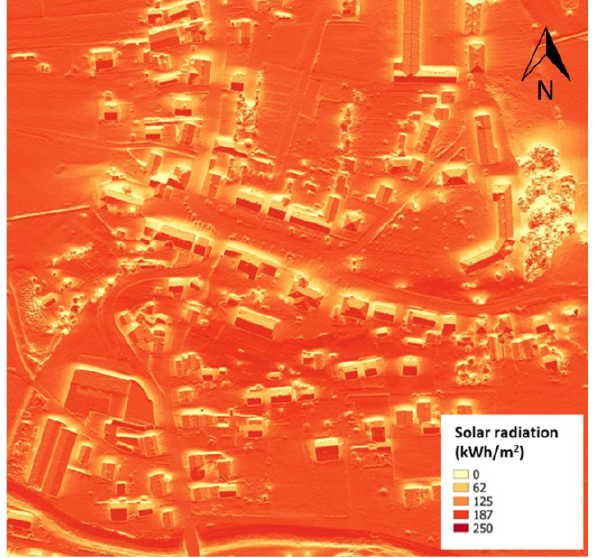
Figure 4. Solar potential of the test area in April